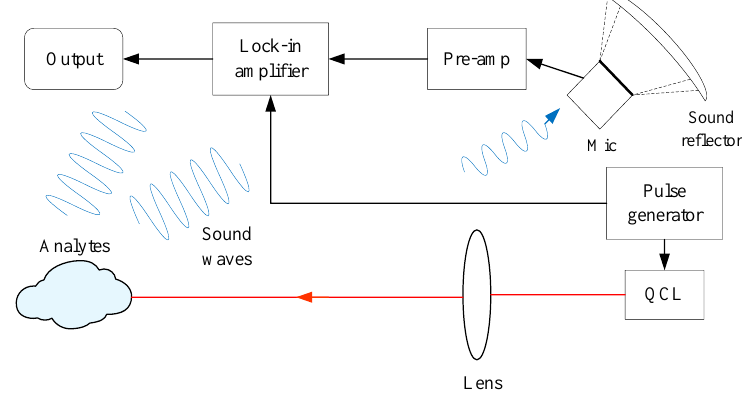
Figure 5. Experimental setup for standoff laser photoacoustic spectroscopy (LPAS) with microphone